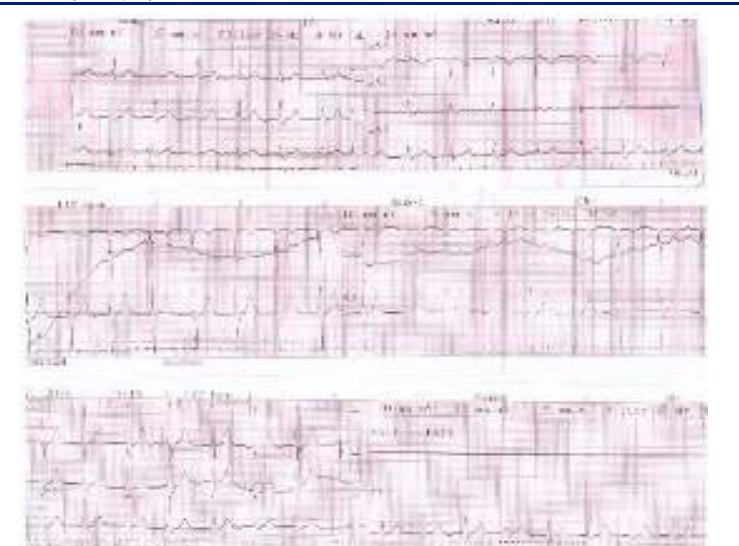
Figure 1 . Twelve-lead electrocardiogram at the initial presentation at an emergency room